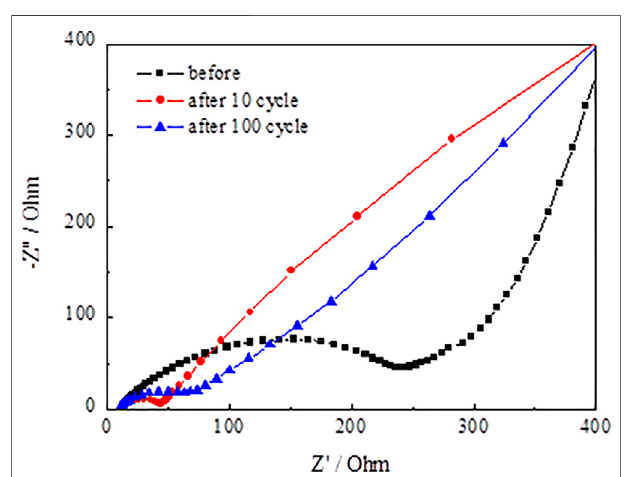
FIGURE 14 | Nyquist plots of SnO 2 @C/graphene.